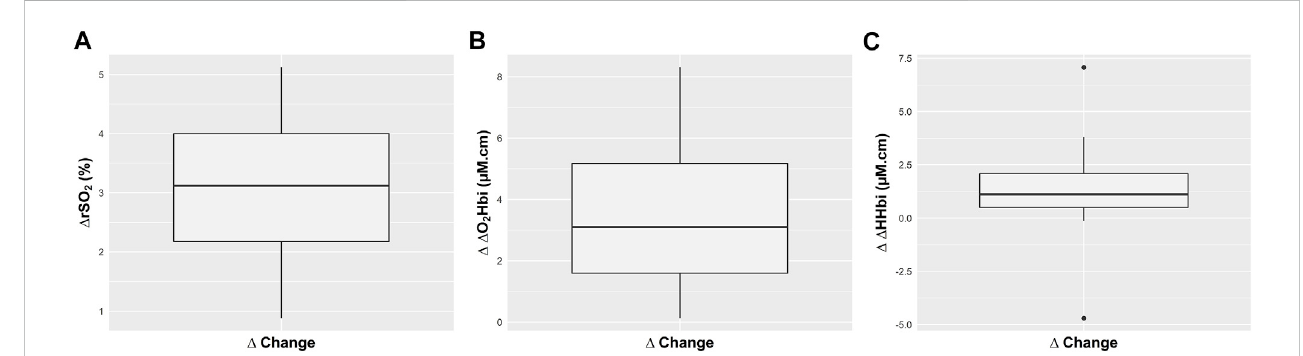
FIGURE 2 Boxplots representing theeffect offraction ofincreased inspiredoxygen (FiO 2 )on absolute changes ( Δ )inregional cerebraloxygen saturation (rSO 2 ) (A) , and in the arterial ( Δ O 2 Hbi) (B) and venous ( Δ HHbi) (C) component of cerebral oxygenation. Values are presented as median and interquartile range.